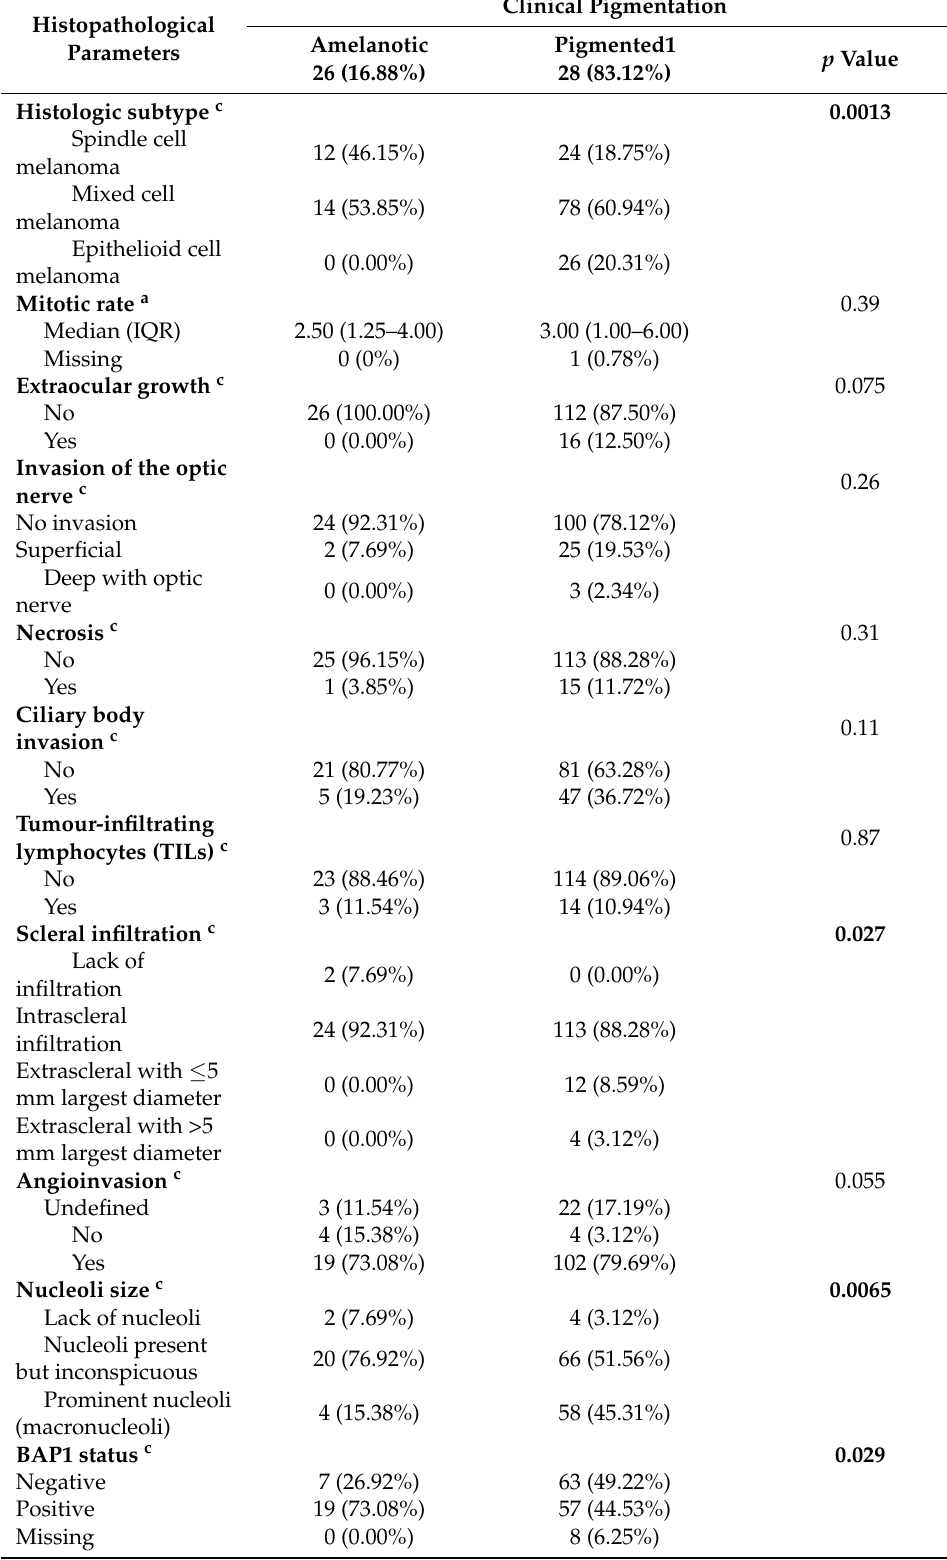
Table 3. Summary of statistics for the relation between amelanotic and pigmented uveal melanoma and histopathological